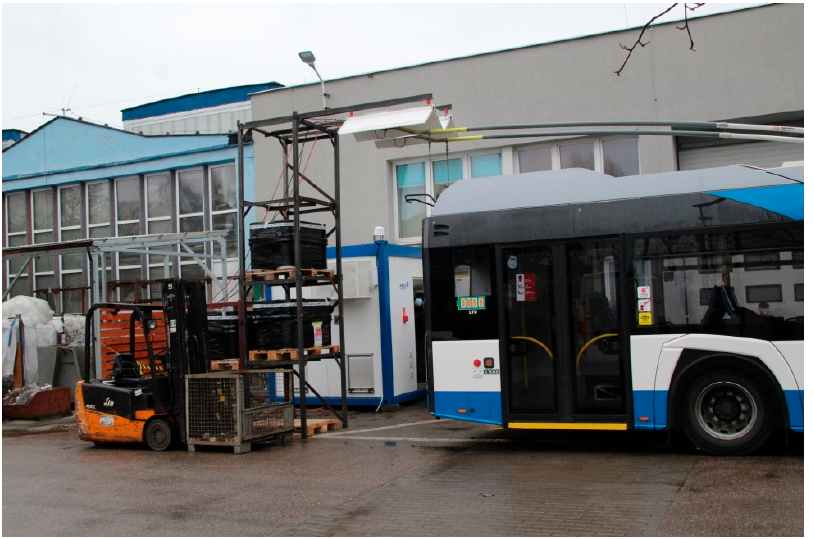
Figure 2. Technical tests of a prototype of a 150 kW fast charging station for trolleybuses in Gdynia (photo taken by M. Bart ł omiejczyk).